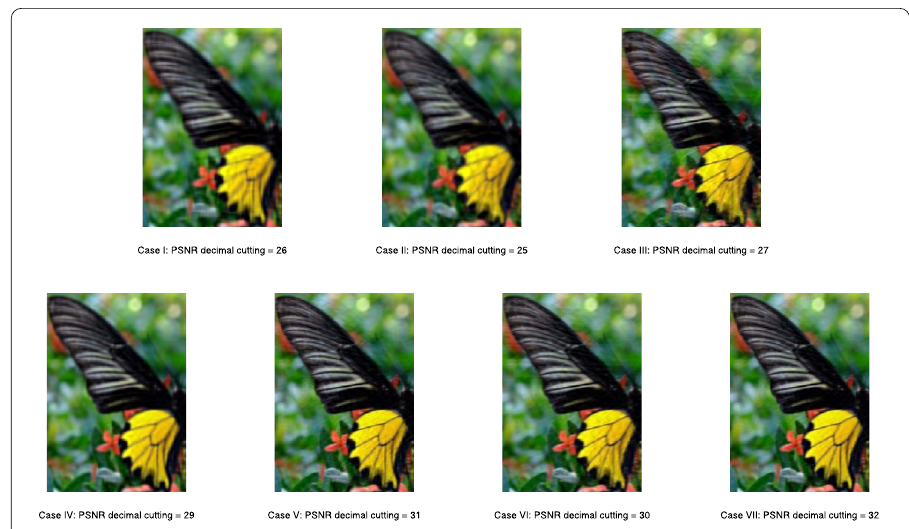
Figure 4 The reconstructed RGB image with its PSNR (decimal cutting) for all cases with the MHPSE algorithm being used, after 500 iterations